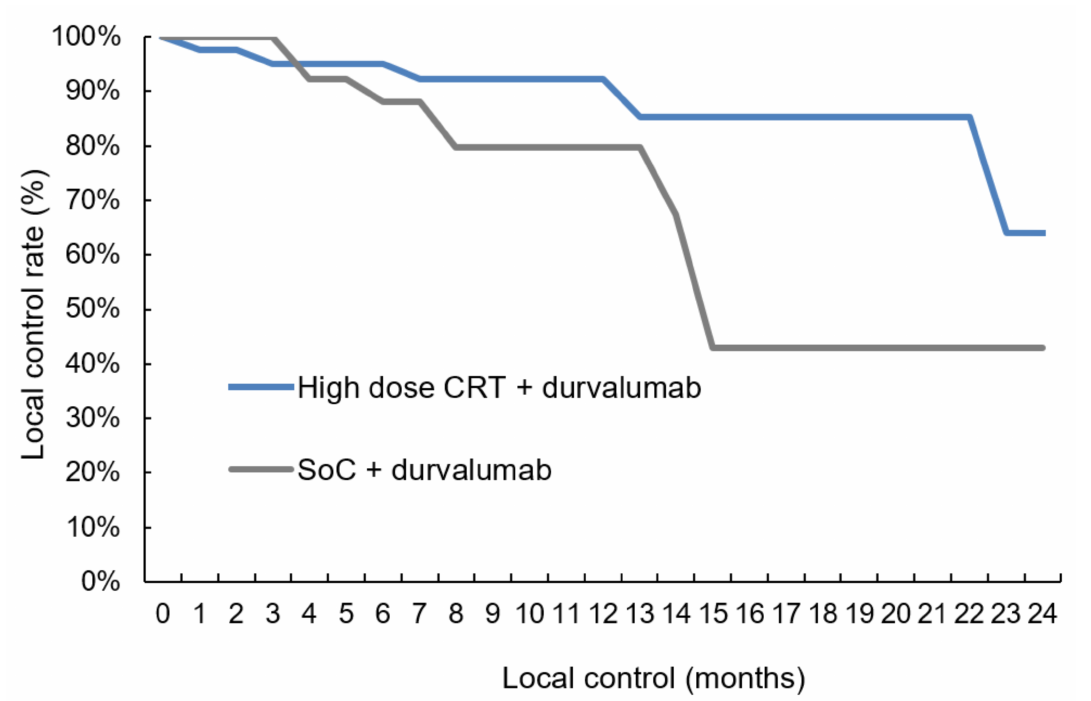
Figure 2. Local control. The comparison showed that local control was tendentially better (log- rank test, p -value = 0.076) in the high-dose chemoradiation group than with SoC treatment: The local control rates at 12 months were 91.8% (Salzburg) versus 79.0% (Vienna), respectively (CRT = chemoradiotherapy, SoC = standard of care).